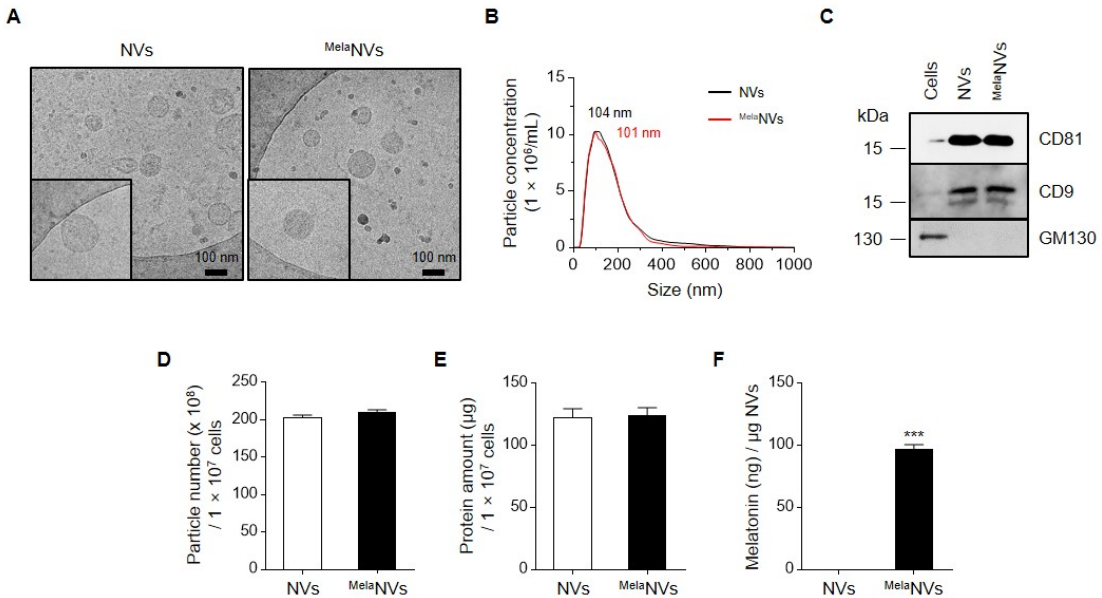
Figure 1. Comparison between extracellular vesicle-mimetic nanovesicles (NVs) and melatonin-loaded extracellular vesicle-mimetic nanovesicles ( Mela NVs). ( A ) Representative images from cryo-electron microscopy data of NVs and Mela NVs. Scale bar, 100 nm. ( B ) Distribution of the observed size of NVs and Mela NVs. Nanoparticle tracking analysis were used for the measurement ( n = 5). ( C ) Western blotting against CD81, CD9, and GM130 for cells, NVs, and Mela NVs (10 µ g of proteins). ( D , E ) Production yield of NVs and Mela NVs in terms of particle number ( D ) and total protein ( E ) when 1 × 10 7 HEK293 cells were used ( n = 5). ( F ) Quantification of melatonin in NVs and Mela NVs using melatonin ELISA kit ( n = 3). Data are presented as mean ± SEM. *** p < 0.001 vs. NVs